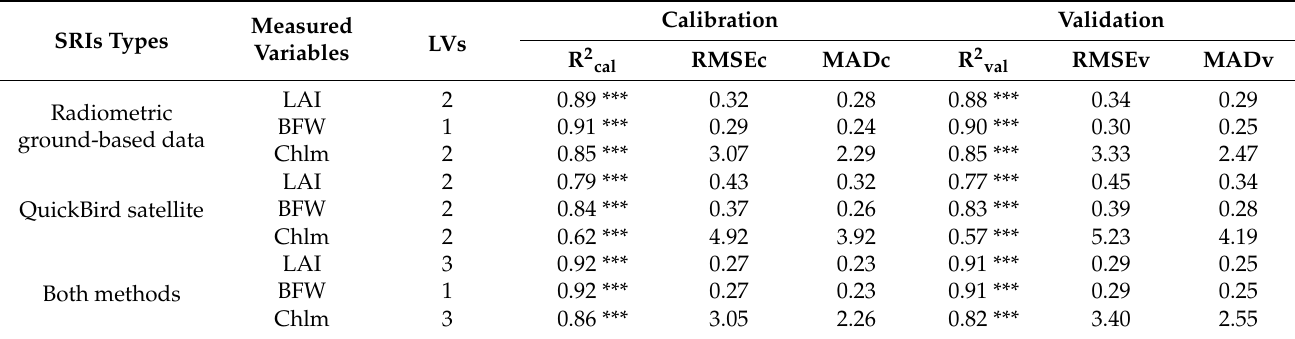
Table 6. Results of calibration (R 2 cal , RMSE C and MADc), and 10-fold cross-validation (R 2 cal , RMSEv and MADv) partial least square regression (PLSR) models of the relationship between selected spectral reflectance indices extracted in Table 1 from radiometric ground-based data, QuickBird satellite and both of them with leaf area index (LAI), biomass fresh weight (BFW) and chlorophyll meter (Chlm) of